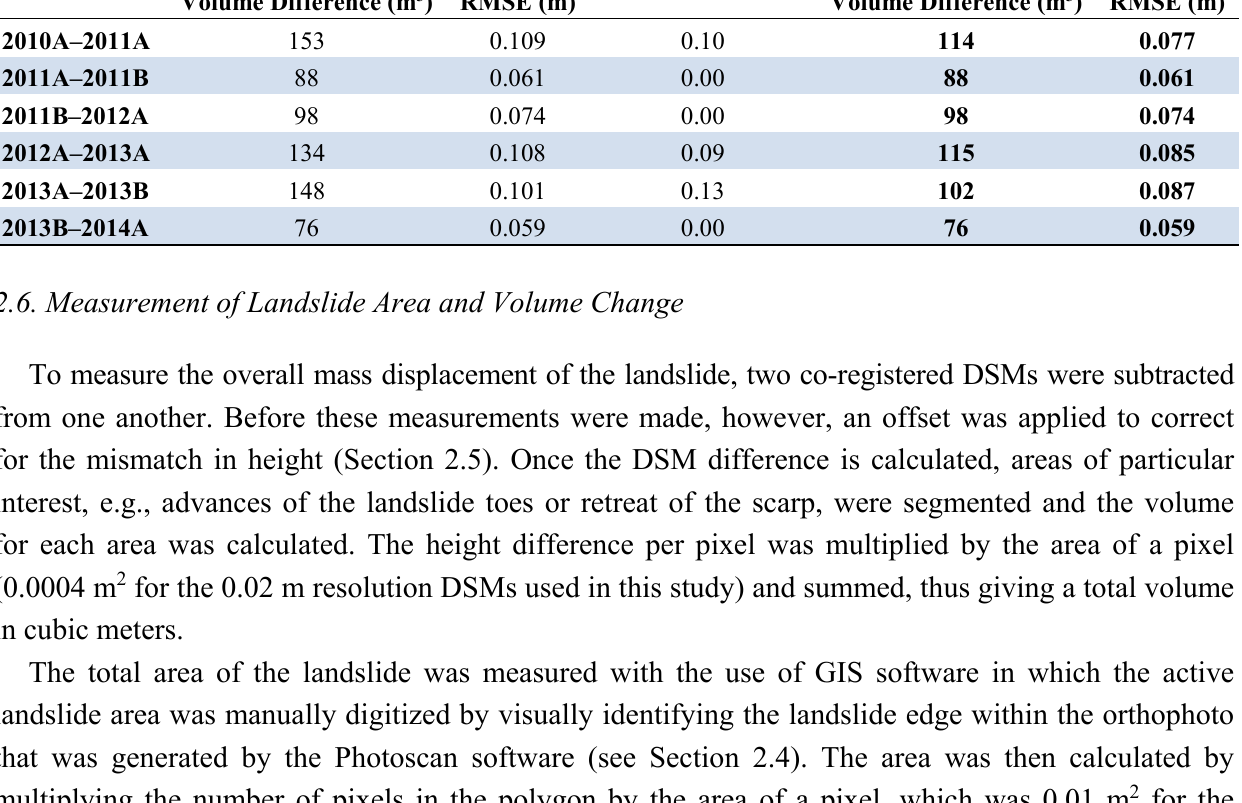
Table 2. Evaluation of relative elevation accuracy for each pair of DSMs before and after offsets were applied, and differences between the DSMs were measured over 4,578,868 pixels (1830 m 2 ) outside the active landslide area. Prior to Offset Application After Offset Application DSM Pair Offset Applied (m) Volume Difference (m 3 ) RMSE (m) Volume Difference (m 3 ) RMSE (m) 153 0.109 0.10 0.077